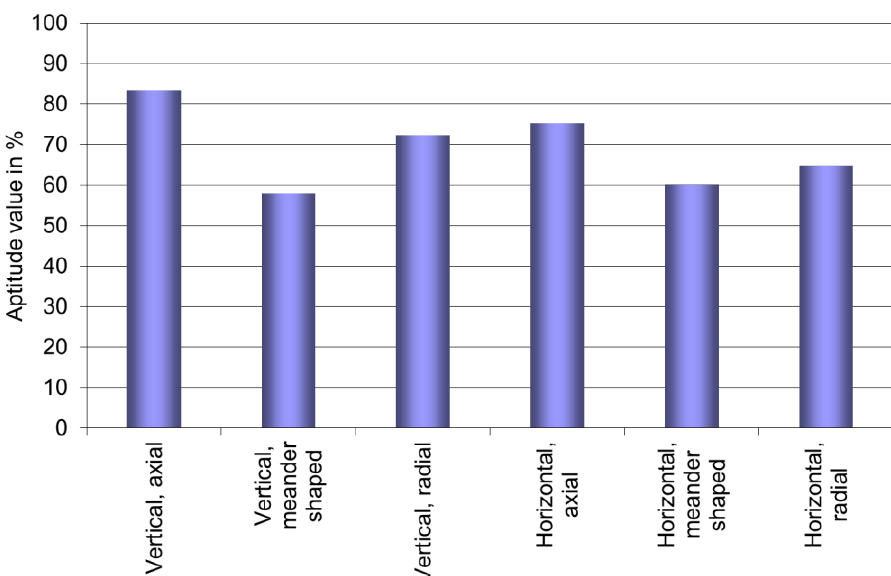
Figure 6. Aptitude values for each concept.